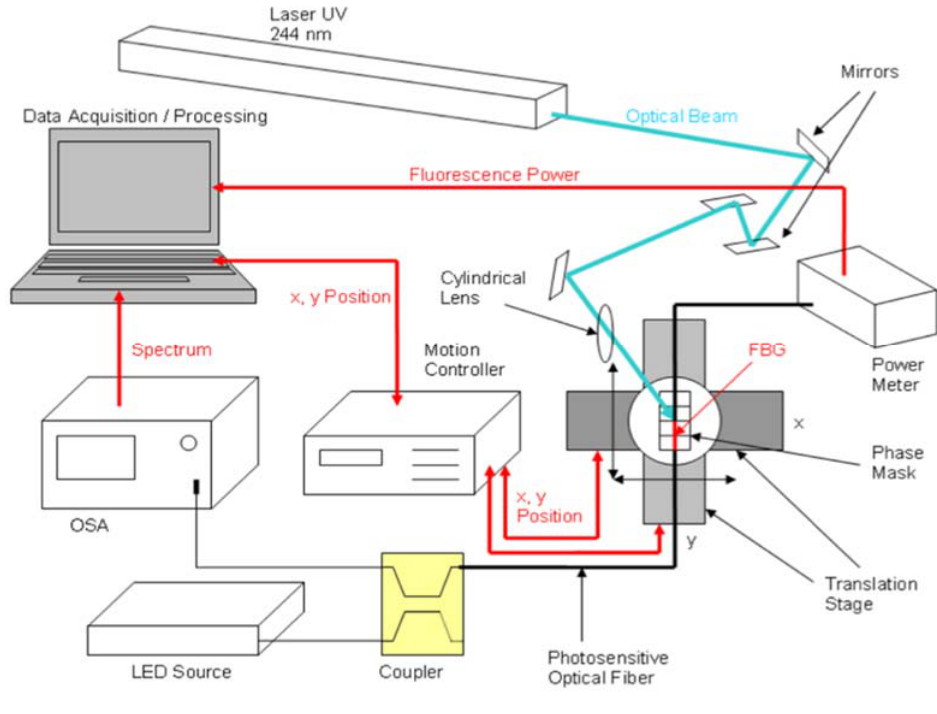
Figure 4. Schematic of phase mask inscription setup.